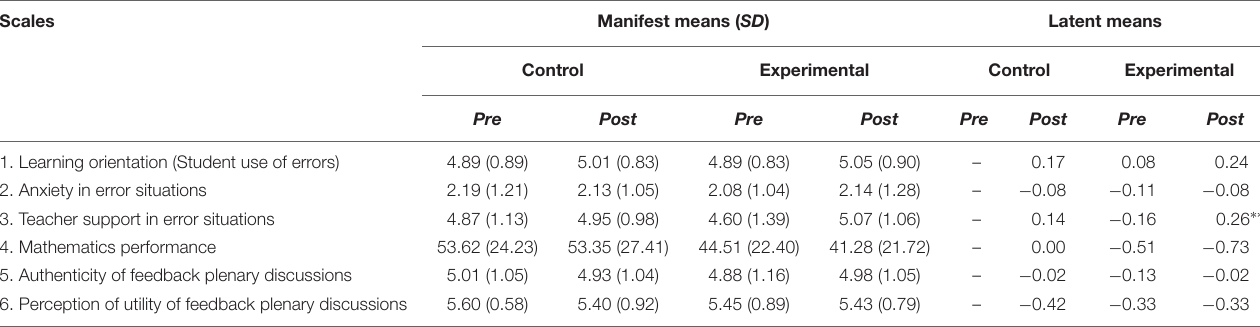
TABLE 3 | Manifest and latent means for